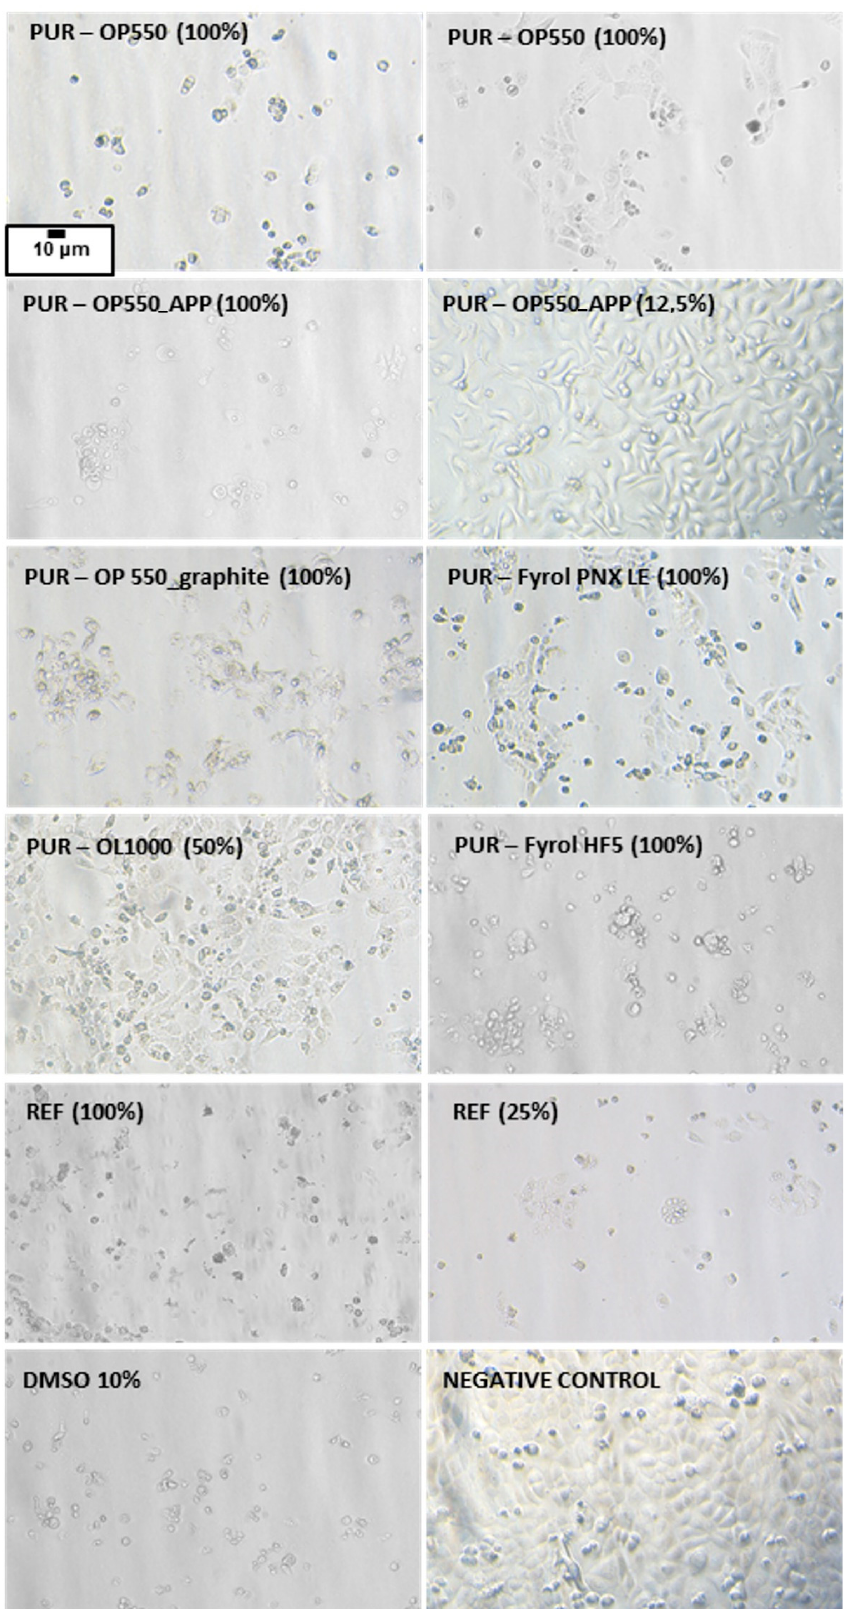
Figure 14. Example microphotographs of human keratinocyte cell line HaCaT after 24-h exposure to PUR extracts. Total magnification: 200× (Nikon Ts2, contrast EMBOSS, Tokyo, Japan).